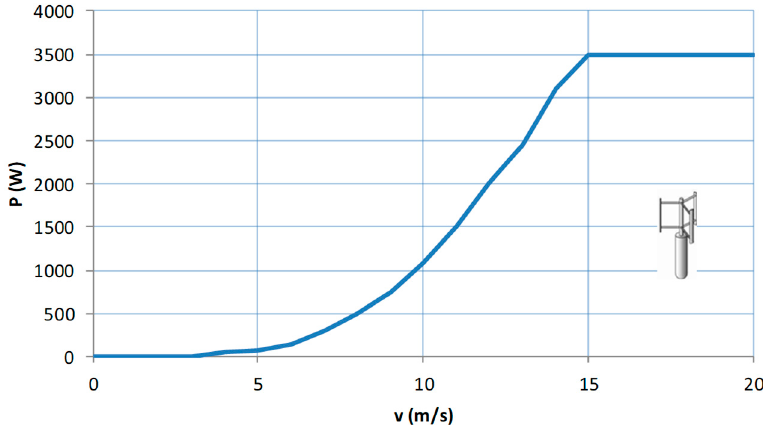
Figure 6. Vertical-axis wind turbine generator (VAWT) power curve for the standard air density ρ std 1.225 kg / cm 2 . Source = 1.225 kg/cm 2 . Source [78].